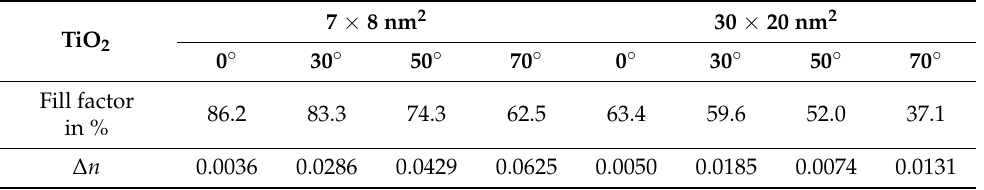
Table 1. Evaluation of the anisotropy for the TiO 2